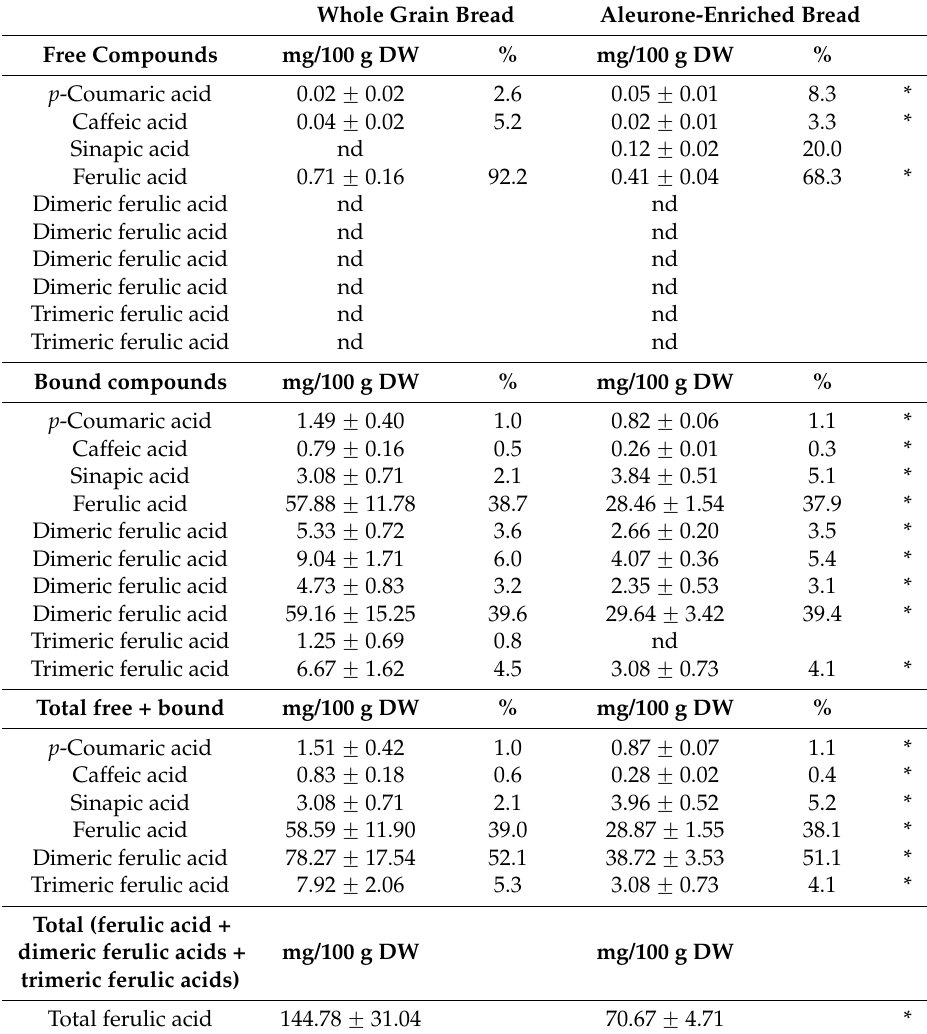
Table 3. Phenolic acids in bread samples. Data are expressed both as content (mg/100 g DW, mean ˘ SD of 6 replicates) and as percentage contribution of individual phenolic acids to the total